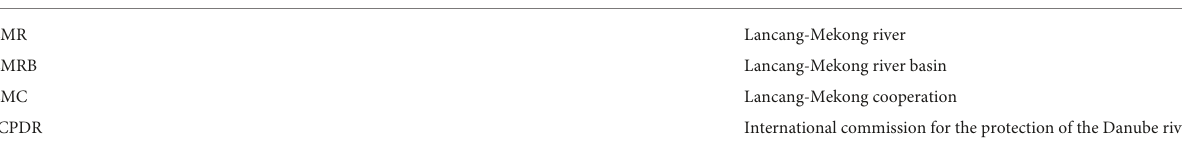
TABLE A1 Abbreviations for this